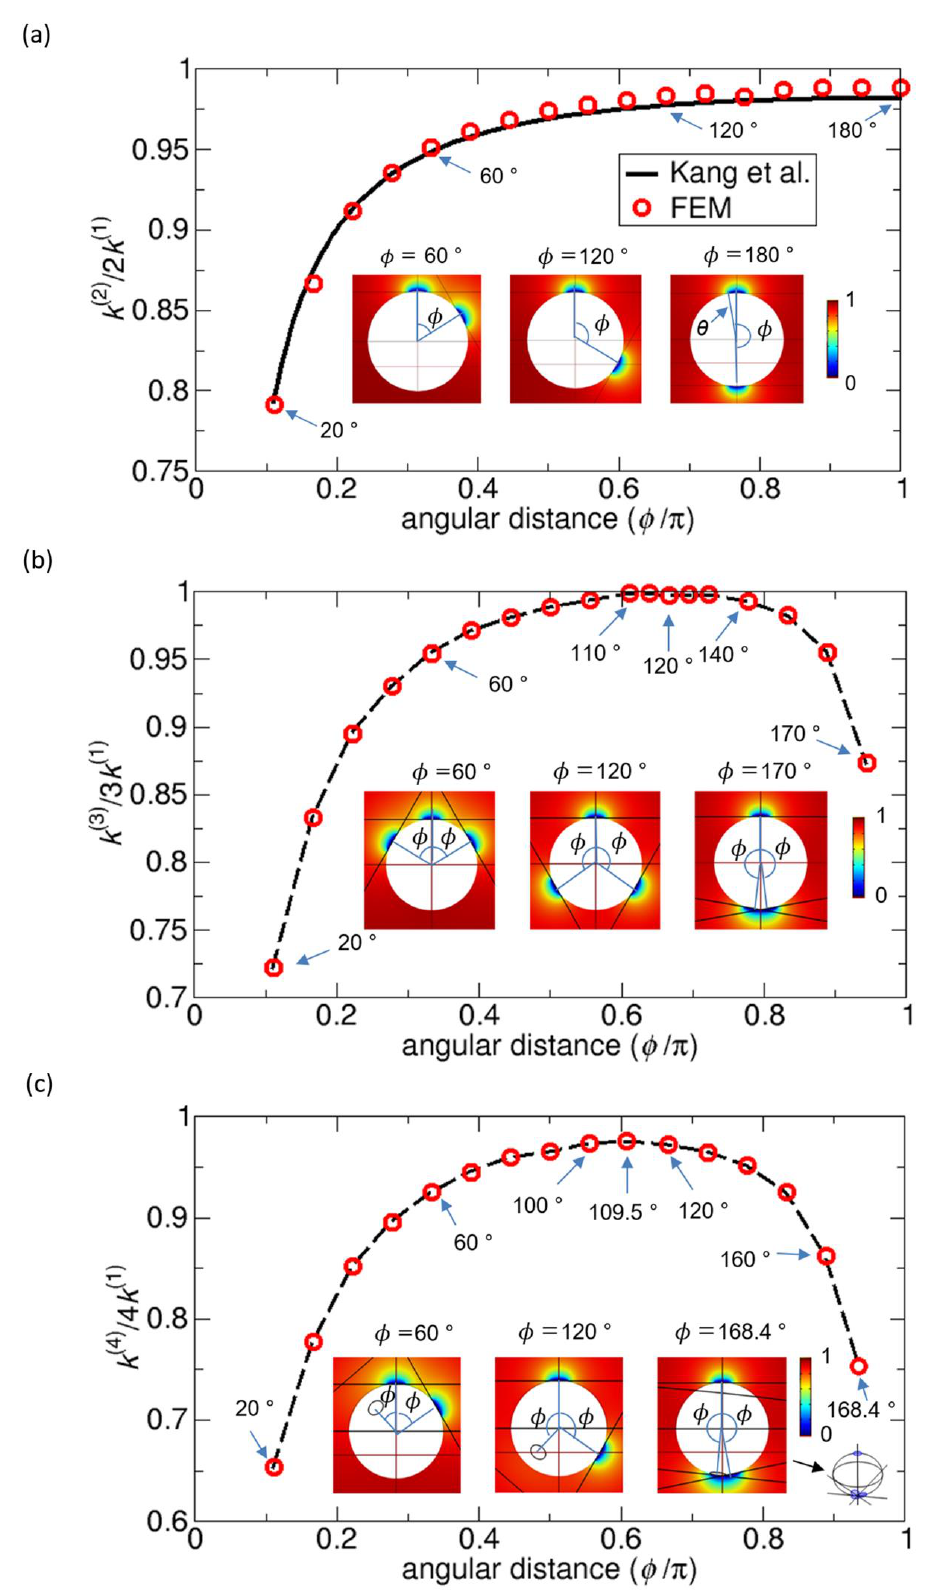
(cid:16) (cid:17) Nk ( 1 ) for N identical disk-like reactive patches on a sphere